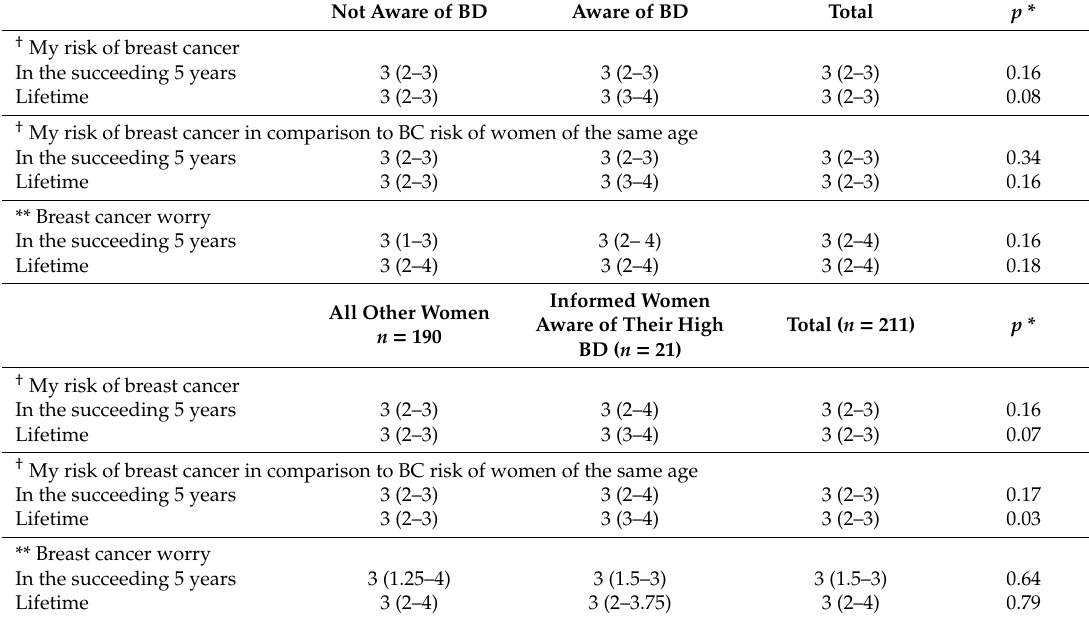
Table 4. Comparison of self-assessed estimates of BC risks and self-assessed estimates of worry about BC development with regards to BD awareness.